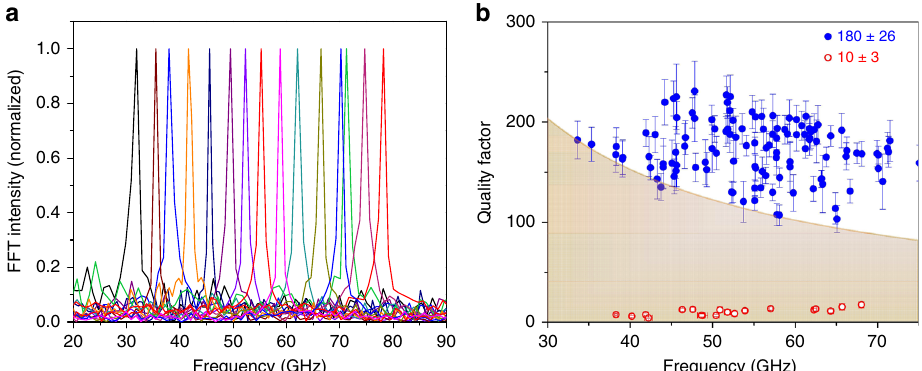
of Au nanoplate vibrations on Lacey carbon fi lms. a Thickness-dependent breathing Fig. 2 Fast Fourier transform (FFT) spectra and quality factors Q br mode vibrations. b Quality factors Q for the different nanoplates. The average quality factor is 180 ± 26, where the error is the standard deviation. For br comparison, Q is 10 ± 3 for Au nanoplates on glass substrates. The solid line on top of the shaded area corresponds to mechanical vibration quality factor br = hf Q ¼ k T . Note that the quality factors were retrieved by fi tting to Eq. (1), not from the FFT B room br